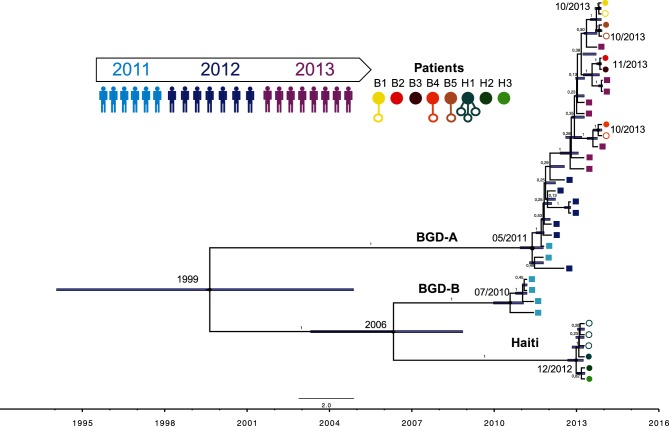
Bayesian phylogenic tree of 35 V. cholerae genotypes sampled over 3 years in Bangladesh and Haiti. The maximum clade credibility tree represents the genealogy of sequences in the study, reconstructed from concatenated hqSNVs, using beast. Coloured squares (shades of blue and purple) represent the time-course isolates collected from Bangladeshi patients from March 2011 to December 2013 (one isolate per patient). Patients for whom we measured intra-host variation (B1–B5 and H1–H3) are shown as circles. Filled circles indicate the putative ancestral genotype, and empty circles indicate putatively derived iSNVs. The median node age and divergence date in months and years are indicated at the nodes. The blue bars represent the 95 % HPD intervals for divergence time estimates, and posterior probabilities are represented on the branches.